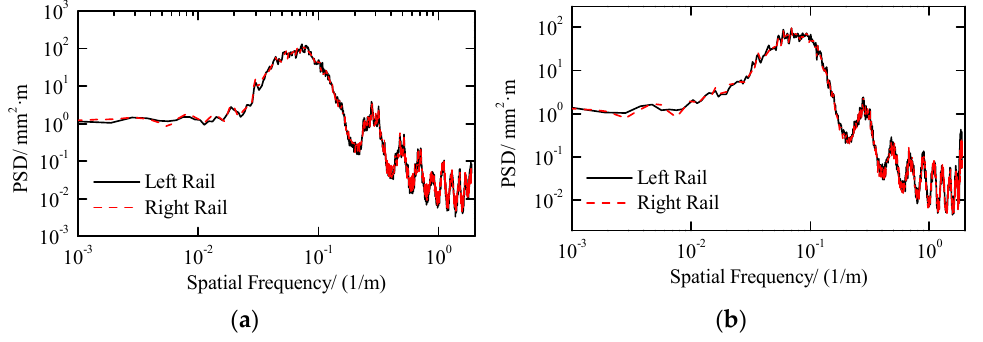
Figure 2. Spectral characteristics of the track geometries: ( a ) the PSD of the level irregularity; ( b ) the PSD of the alignment irregularity.